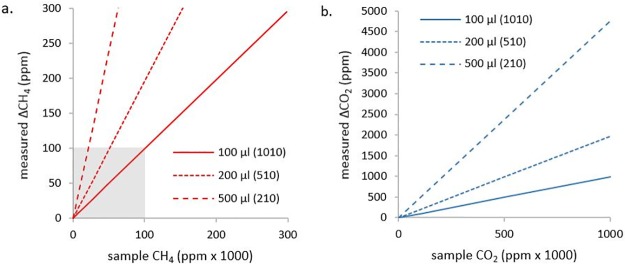
a. and b. measured ΔX (a. CH4 and b. CO2) concentration (y-axis) vs. sample concentration (x-axis) for three injection volumes 100, 200 and 500 μl, respectively.Legend values in brackets are the dilution factor (Vloop-Vsample)/Vsample. The shaded area in (a.) shows the linear response range for CH4.